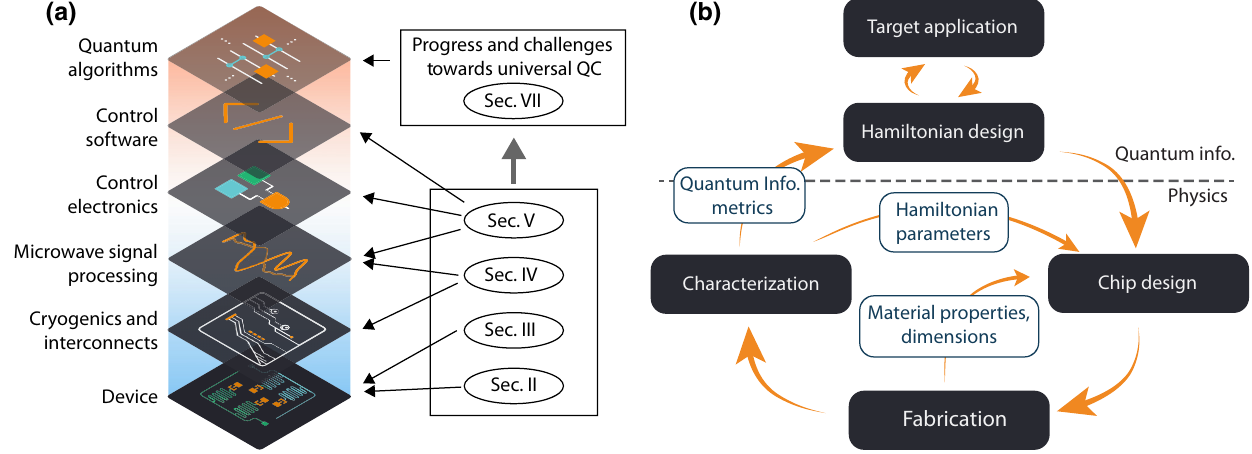
FIG. 1. Overview of the crucial hardware building blocks and experimental processes in realizing a quantum system in cQED . (a) The full stack of cQED quantum computer. Each layer represents an important element that must be carefully constructed and optimized, in order to construct full-stack quantum processors in cQED. (b) The engineering cycle of a cQED device. The desired target application influences the chip’s Hamiltonian design (Sec. II) in which an equivalent circuit and its target parameters are deter- mined. This design serves as the input for a second design step in which the geometry and layout of the device is determined, taking into account the constraints of the fabrication process (III). After fabricating the device, the system is carefully characterized (V) and the resulting information is used to inform the next design iteration to bring the system closer towards the desired